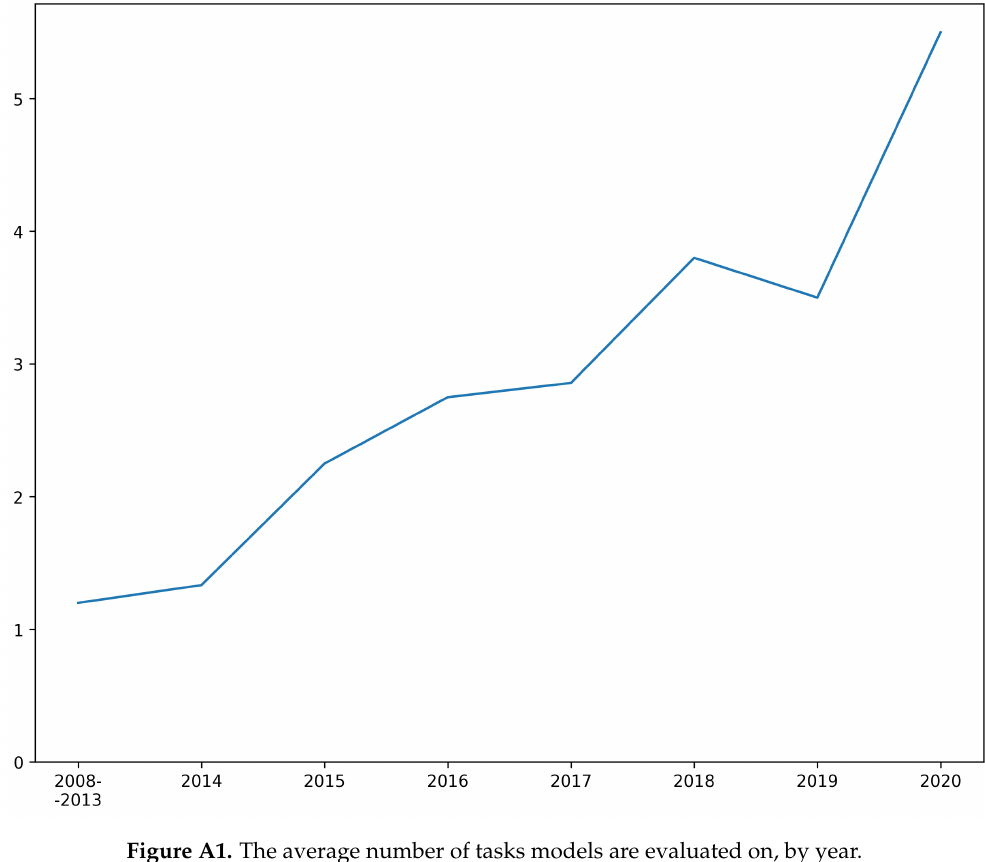
Figure A1. The average number of tasks models are evaluated on, by year.